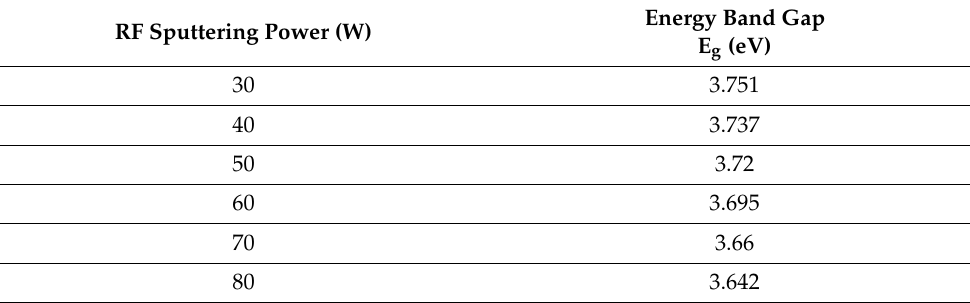
Table 2. Energy bandgaps for different WO x films. RF Sputtering Power